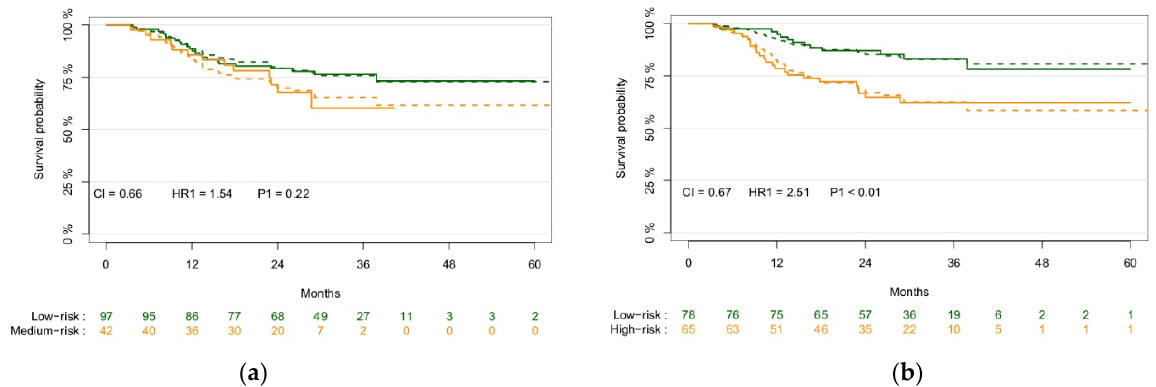
Figure 2. Kaplan–Meier survival plots of the validation cohort ( n = 139) stratified based on the previously created signature ( a ) and the newly created signature ( b ), showing the p -value of the split between risk groups and model performance through the CI and the HR between the risk groups. The solid lines represent the observed survival curves, and the dashed line the corresponding predicted survival curves.